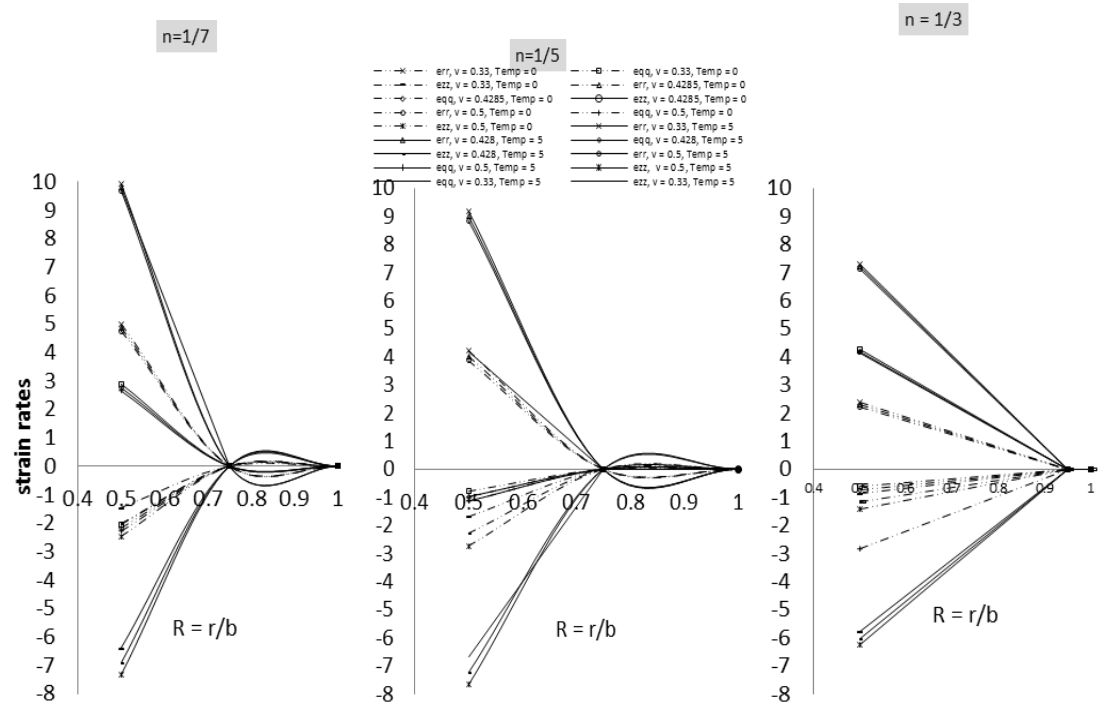
Figure 6(b). Strain rates distribution in disc along the radii ratio R = r/b at angular speed W = at angular speed 2 10